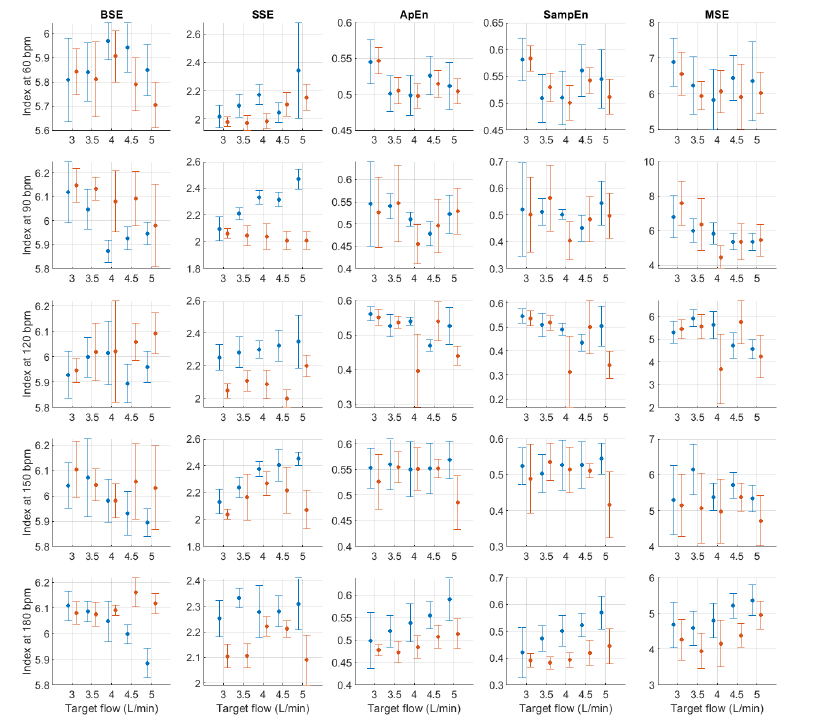
Figure A19. Mean and standard deviation of entropy-related indices extracted from pulse rate variability under different stroke rates (SR) and target flows (TF, TF above 2.5 L/min) conditions, and measured from the radial (blue) and deep palmar arch (orange)